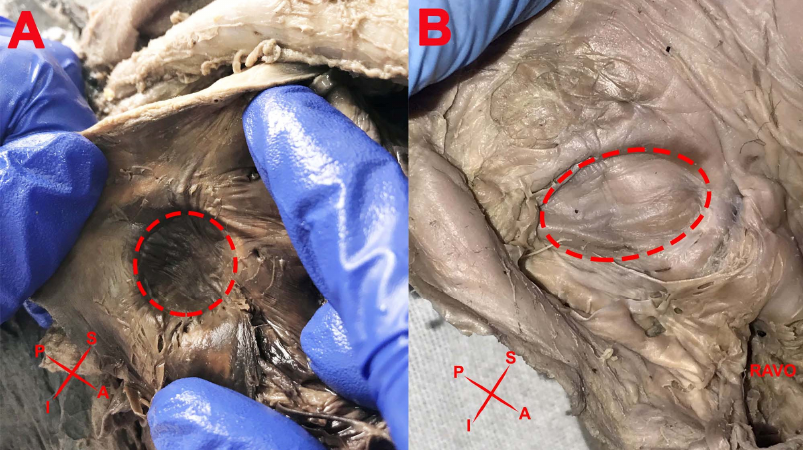
Figure 1. Shape of the FO: ( A ) Circular; ( B ) Oval. RAVO—right atrioventricular orifice . The aspect of the FO was smooth in 15 specimens (48.38%) and has a net-like struc- ture or was cribriform in 16 specimens (51.62%). Cribriform FO presents the fibrous- strands, different from the Chiari network, described in the literature as a mobile reticu- lated network structure originating from the Eustachian valve, connecting to other parts of the right atrium [10,11]. In the 16 specimens, these net-like structures were observed in: (1) Six specimens (37.5%), on the entire surface of the FO; (2) Six specimens (37.5%), on the posteroinferior part of the FO; (3) Four specimens (25%), only on the inferior part of the FO.